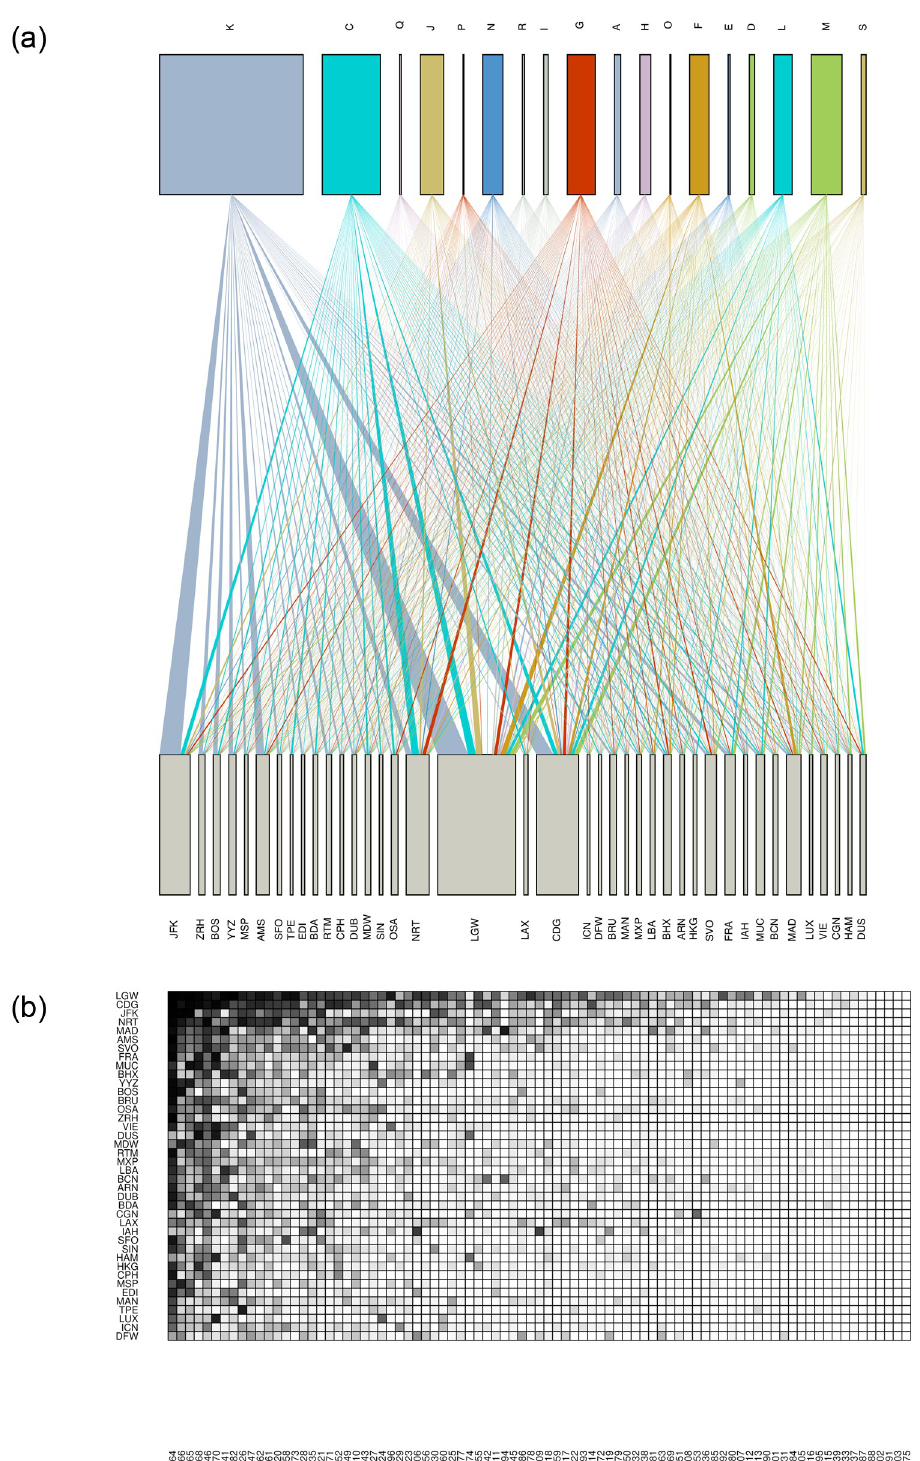
Fig 1. The city-activities of globalized firms network. [a] The bipartite network of cities and economic sections (NACE Rev. 2). [b] The adjacency matrix using the economic activities at NACE Rev. 2 (2-digit). The figures have been generated using R